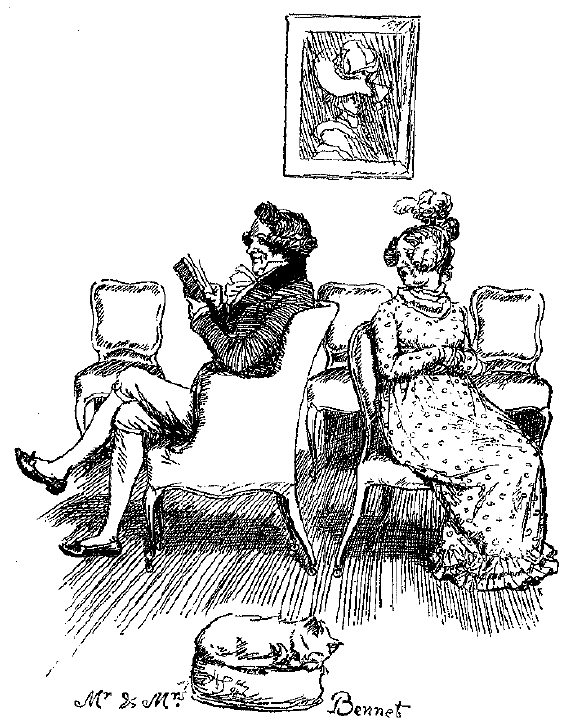
Figure 1. Hugh Thomson’s illustratio n for Pride and Prejudice (Austen [1894] 2005), p.